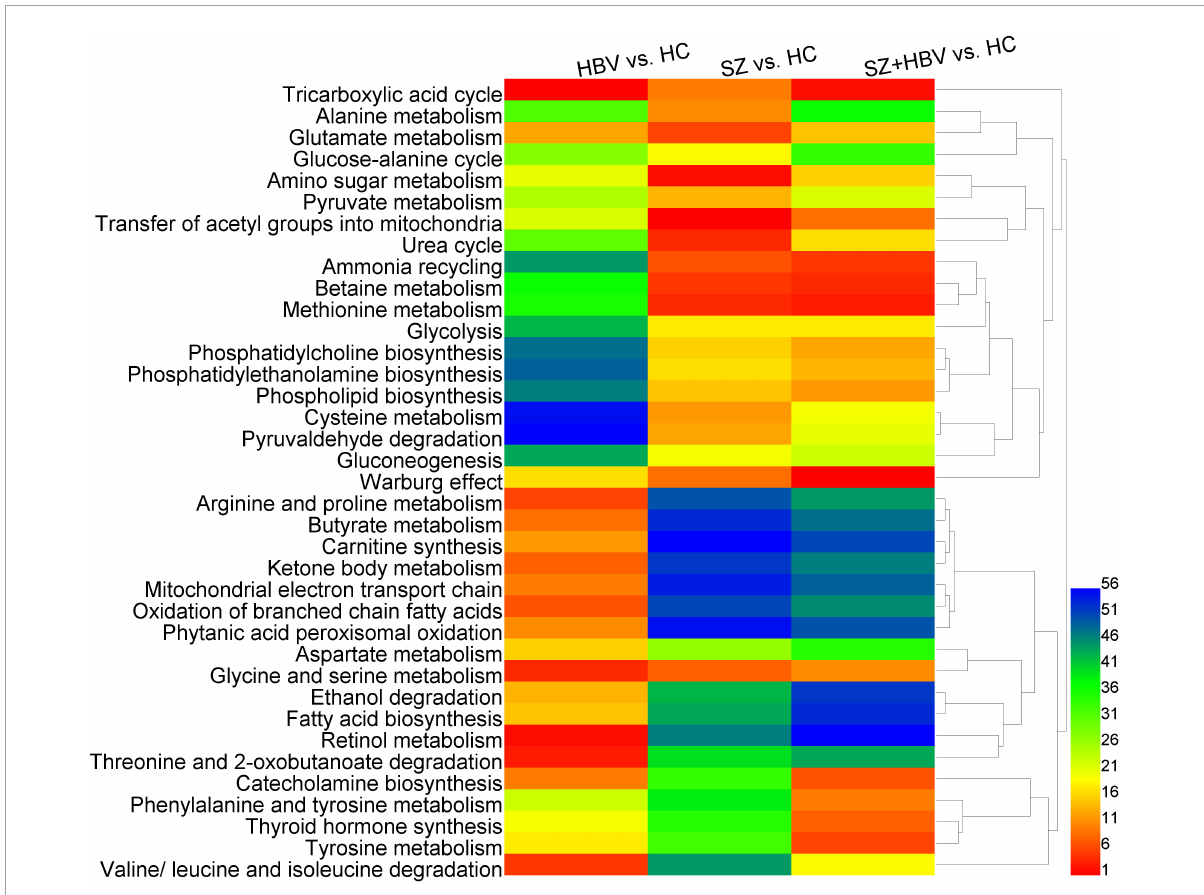
FIGURE4 Heat-map of perturbed metabolic pathways. Columns represent different comparison models: HBV vs. HC, SZ vs. HC, and SZ + HBV vs. HC; and rows represent metabolic pathways, respectively. The significance order of metabolic pathways was color encoded (red representing the most important and blue the least important). The unsupervised hierarchical clustering of metabolic pathways reveals the relationship between different pathways (shorter branch corresponds to stronger